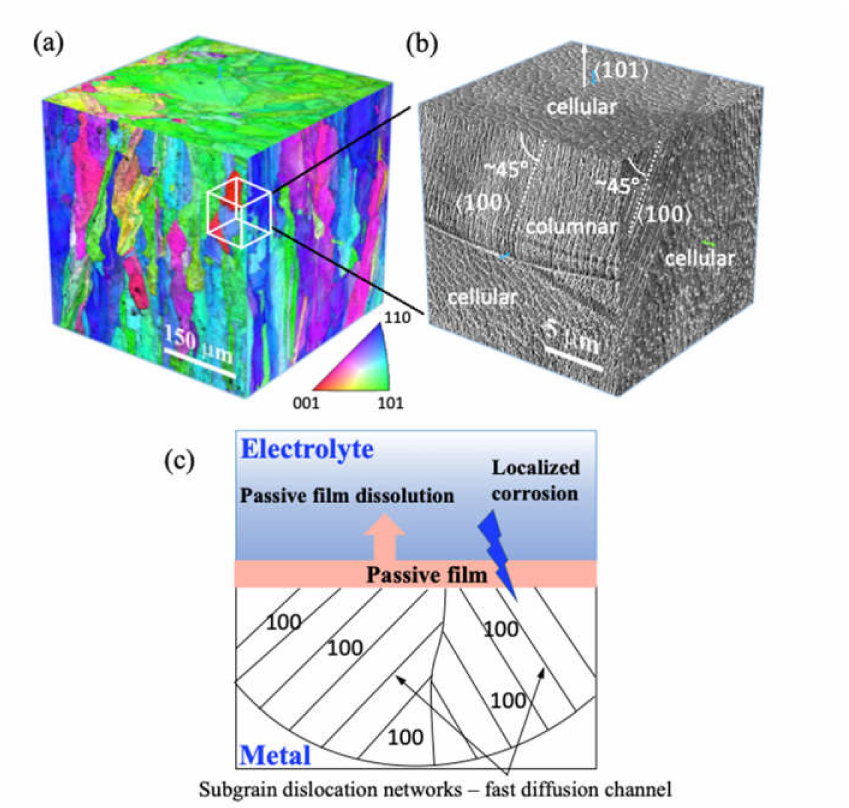
Figure 8. ( a ) Crystallographic planes and ( b ) orientation of the subgrain dislocation network on three coordinate planes, constructed from the EBSD-IPF and SEM images of the sample printed at P = 240 W, H = 50 µ m (sample 6 in Table 1), ( c ) schematic of the role of dislocation cellular structure in promoting element